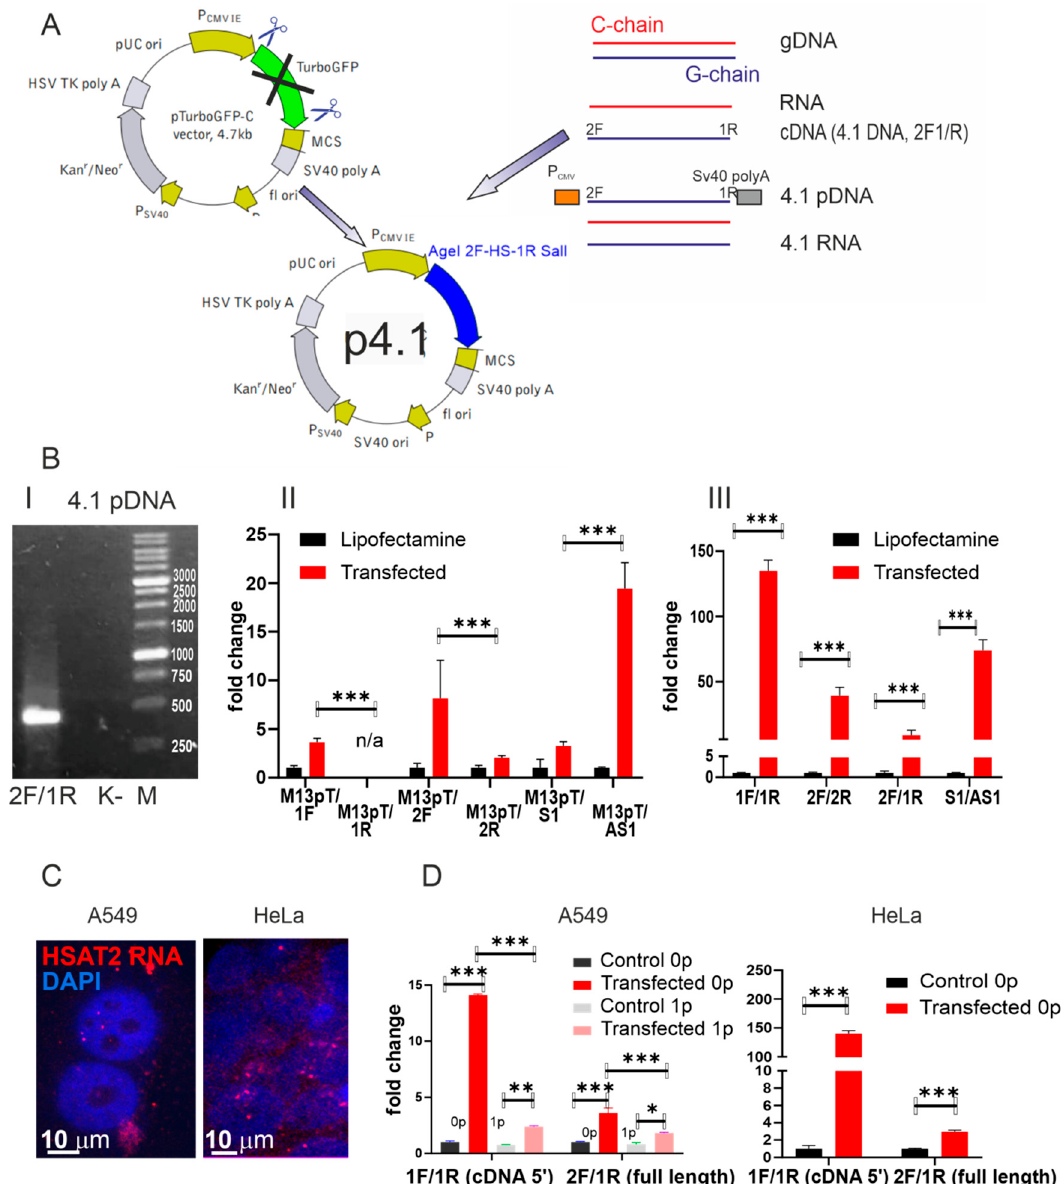
Figure 3. Genetic construct for HSAT2 (Acc No OP912406.2) overexpression. ( A ) Scheme of cloning (see the Materials and Methods Section 4 for details). ( B ) Panel I—OP912406.2 amplification with 2F/1R primers using p4.1 plasmid as a template. K − —NTC control; M—molecular weights (bp) marker (Sibenzyme, Russia). Panel II—qPCR quantification of A549 M13-oligo-dT cDNA (see Section 4.6 of Materials and Methods) with a different set of primers (see Table 2 for primer sequences and abbreviations) to prove (a) the amplified cDNA originated from the cloned sequence but not from genomic DNA and (b) it can be amplified with the S1/AS1 primer pair from our previous work. Panel III—qPCR with different primers set to quantify different parts of the transcript cDNA (1F/1R—5 (cid:48) of cDNA; 2F/2R—3 (cid:48) of cDNA; 2F/1R—the whole transcript; S1/AS1—amplification with previously described primers to prove the sequence homology with the previously described transcript). ( C ) DNA-RNA FISH of transfected A549 and HeLa cells. HSAT2 probe is shown in red, nuclei are counterstained with DAPI (blue), and scale bars are shown in the images. ( D ) Quantification of 4.1 (Acc No OP912406.2) transcription before and after the first splitting. *— p < 0.05, **— p < 0.01, and ***— p <